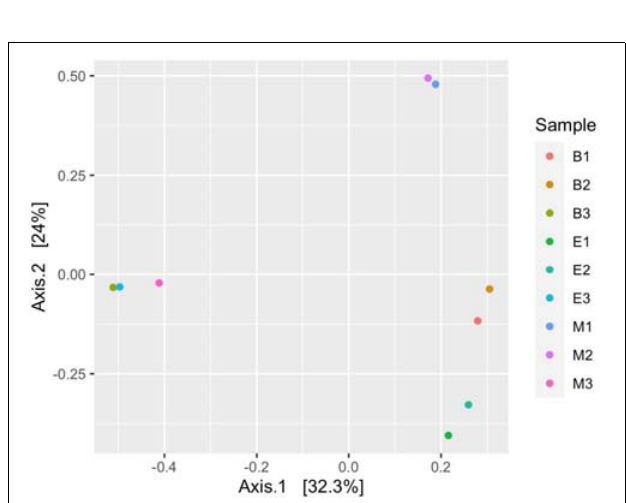
FIGURE 9 | Prokaryote (ASV level) compositional dissimilarity among samples, based on the Bray–Curtis dissimilarity (non-phylogenetic relatedness). Each sample is represented as a dot and is colored distinctly based on wetland sediment and primer combination. The abbreviations and numerics used are as follows: B, Bhomra; E, EKW; M, Malencho; 1, 341b4_F/806_R; 2, N341b4_F/806_R; 3, Pro341F/Pro805R; ASV, amplicon sequence variant; EKW, East Kolkata